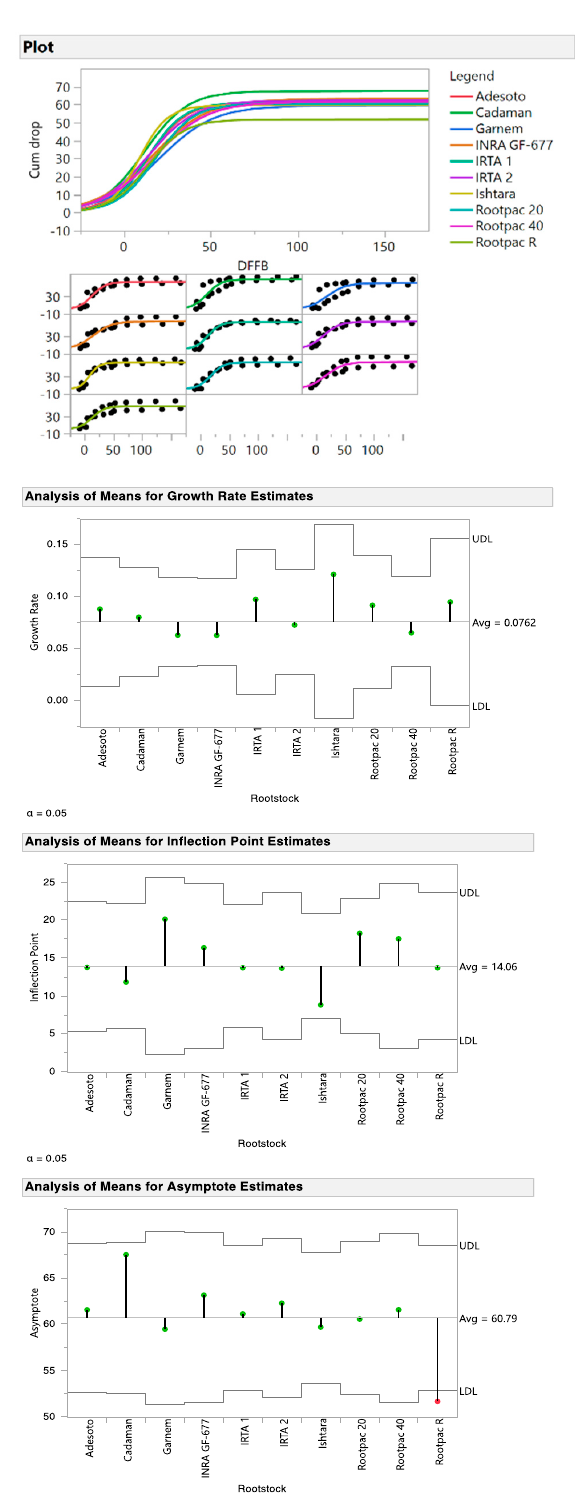
Figure 4. Fitted curves and parameter comparison for the logistic three-parameter models fitted to describe the relationship from bud break until 180 days after full bloom between cumulative fruit drop (%) and days from full bloom (DFFB) for ‘Marinada’ grafted onto Adesoto, Cadaman ® , Garnem ® , INRA GF-677, IRTA 1, IRTA 2, Ishtara ® , Rootpac ® 20, Rootpac ® 40, and Rootpac ® R rootstocks at Les Borges Blanques, Spain (P2). Data were recorded during 2017–2018.